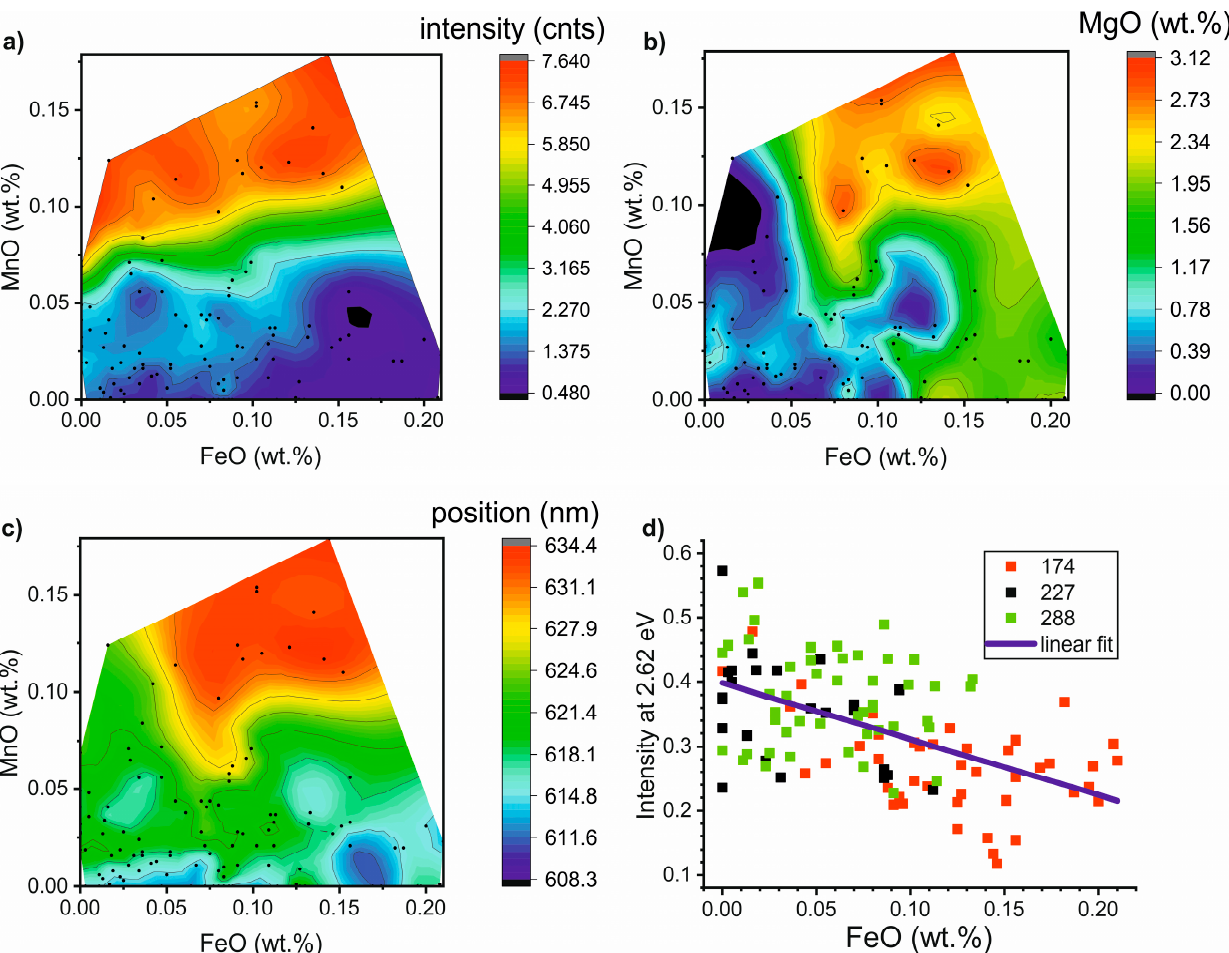
Figure 9. Correlation between calcite chemistry and CL-spectra parameters: ( a ) intensity of extrinsic luminescence (approximated by amplitude of single Gaussian curve) versus molar fraction of Fe and Mn; ( b ) molar fraction of Fe- and Mn- vs. Mg-admixture of calcite; ( c ) position of the maximum of single Gaussian curve vs. molar fractions of Fe and Mn; ( d ) quenching effect of Fe-admixture on the intensity of intrinsic luminescence of calcite. Sample No. 174—Raspenava, sample No. 227—Bohdane č , sample No. 288—Nedv ě dice.